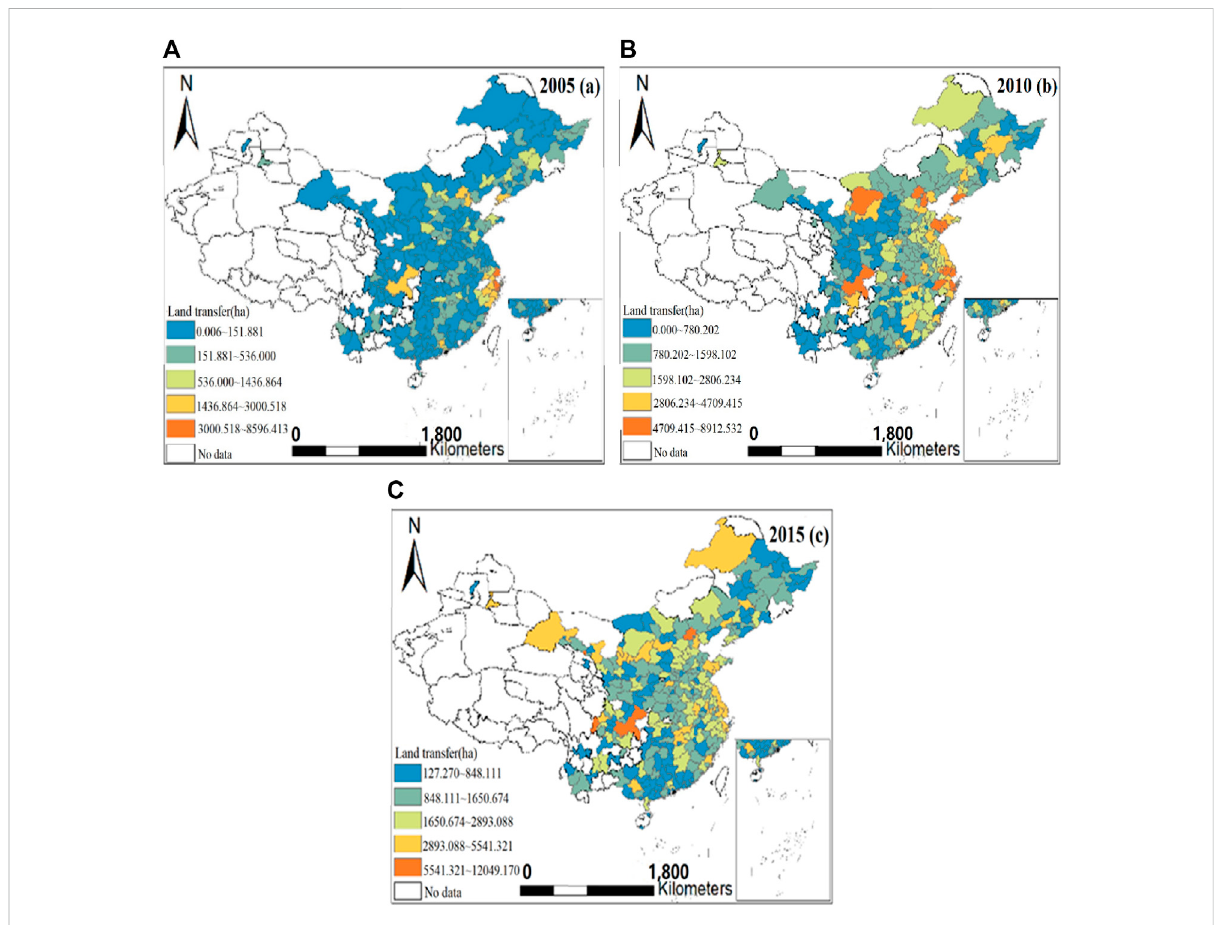
Land transfer area; (A) for 2005, (B) for 2010, (C) for